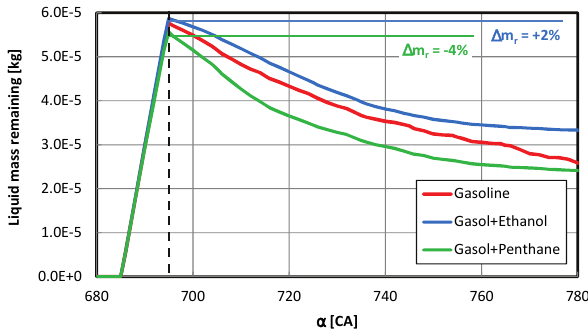
Fig. 15. The effect of the unevaporated dose quantity in the combustion chamber on the fuel type during its injection and spray Different fuel properties mean that it is important